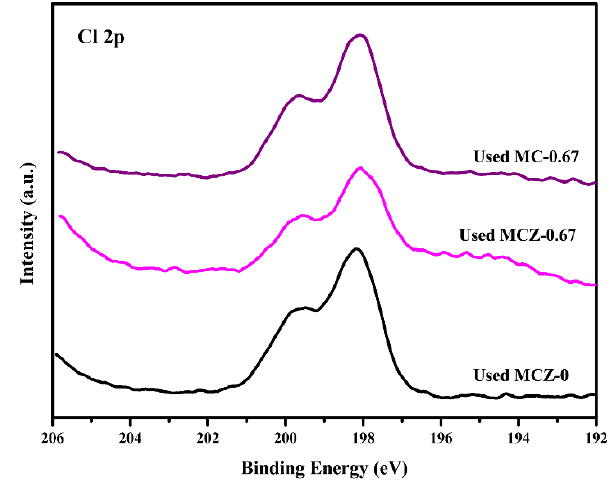
Figure 9. Cl 2p XPS spectra of the used MCZ-0, MCZ-0.67 and MC-0.67 catalysts.